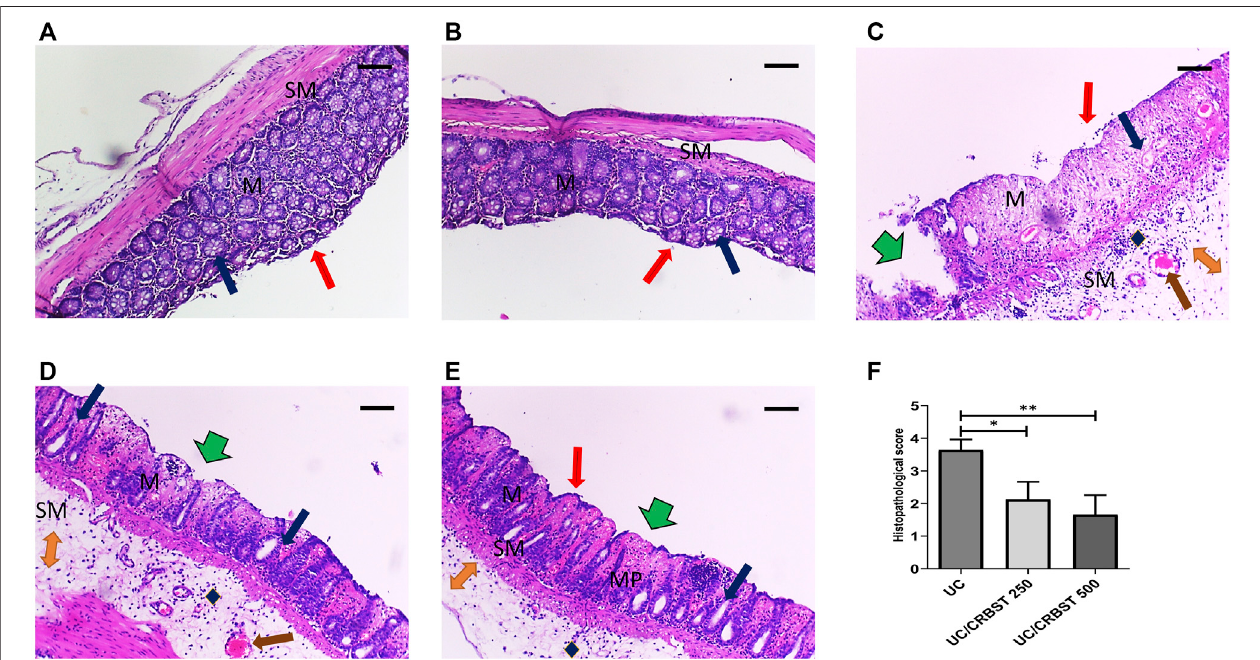
FIGURE 2 | Effect of CRBST 250 and 500 mg/kg on histopathological characteristics and histopathological score in rats with AA-induced UC. Representative histological appearanceofcolontissue specimensstained withH&Efrom Normal (A) and CRBST 500 (B) control groupsshowingnormal epithelium(redarrow), normal colonic mucosa (M) and submucosa (SM), crypts and glands (blue arrow); Colonic sections from UC group (C) showing deepithelialization (red arrow), erosions (green arrow), disrupted mucosa (M) and submucosa (SM), in fl ammatory cell in fi ltration (blue diamond), edema (orange double arrow), congestion (brown arrow) and complete necrosis of the crypts (blue arrow); Colonic sections from UC/CRBST 250 (D) and UC/CRBST 500 (E) showing a moderate restoration of architecture, with decreased super fi cial ulceration of the intestinal mucosa (green arrow) and is associated with a marked decrease of interstitial in fl ammatory cell in fi ltration in (blue diamond),lowerdegree ofglands damage(blue arrow),lower degree ofedema (orange doublearrow),normal muscularis propria (MP),congestion stillapparent(brown arrow). Results in (F) are shown as the median ± interquartile range (n = 6). *** p < 0.001. Normal, normal control rats administered the vehicle; CRBST 500, normal rats administered carbocisteine (500 mg/kg); UC, AA-induced UC rats administered the vehicle; UC/CRBST 250, AA-induced UC rats treated with carbocisteine (250 mg/kg); UC/CRBST 500, AA-induced UC rats treated with carbocisteine (500 mg/kg). H&E stain, X 100, bar = 200